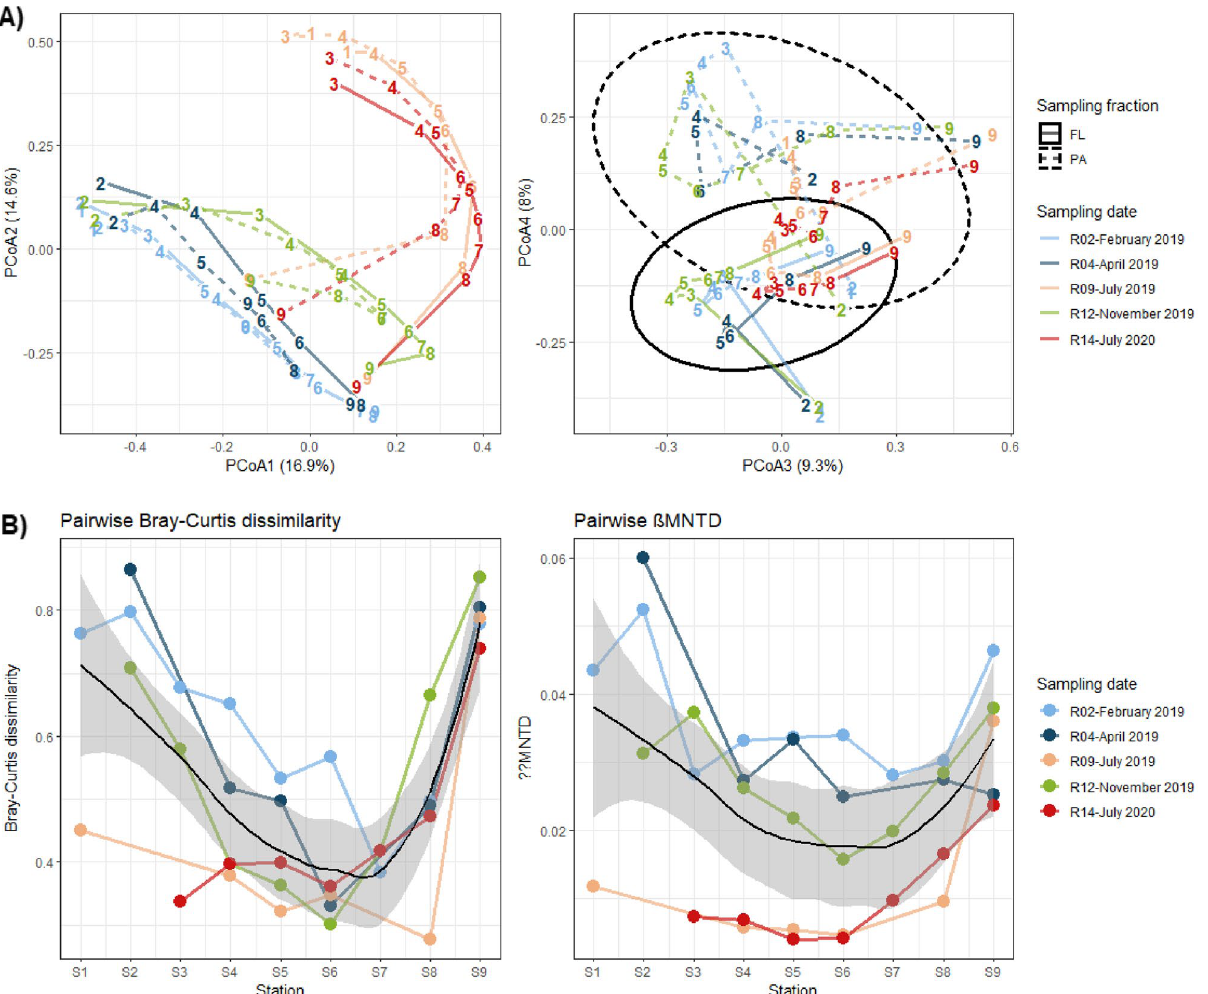
Figure 5. (A) PCoA ordination of all samples based on the Bray–Curtis dissimilarity (left: axes 1–2; right: axes 3–4). The lines link the different stations within one sampling time in their spatial order (S1–S9) (solid line: FL communities, dashed line: PA communities). Samples are labeled as stations. (B) Pairwise Bray–Curtis and abundance-weighted βMNTD dissimilarity between the FL and PA fractions for each sample. The black line represents the loess regression curve and the dark area represents its confidence